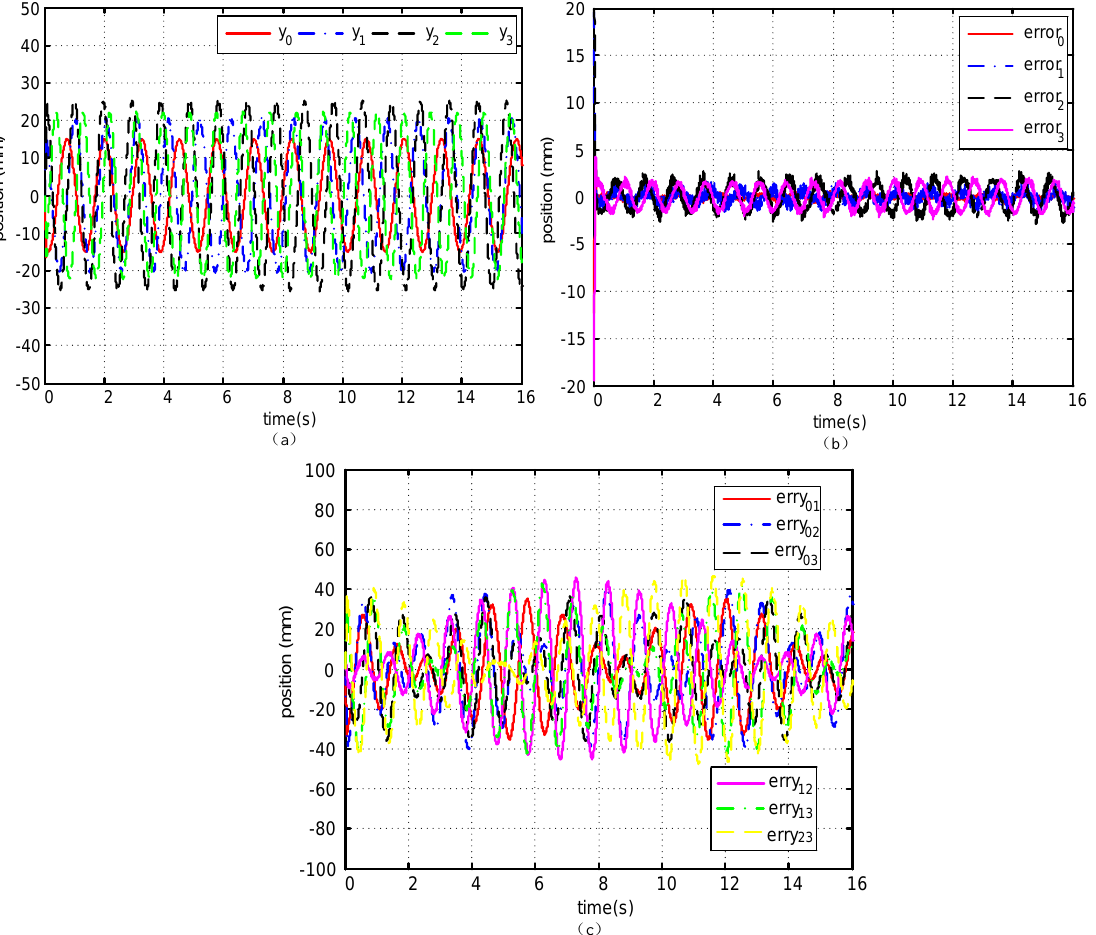
Figure 9. Dynamic position response waveforms: ( a ) actual, ( b ) error, and ( c ) relative position signals under low-level tracking